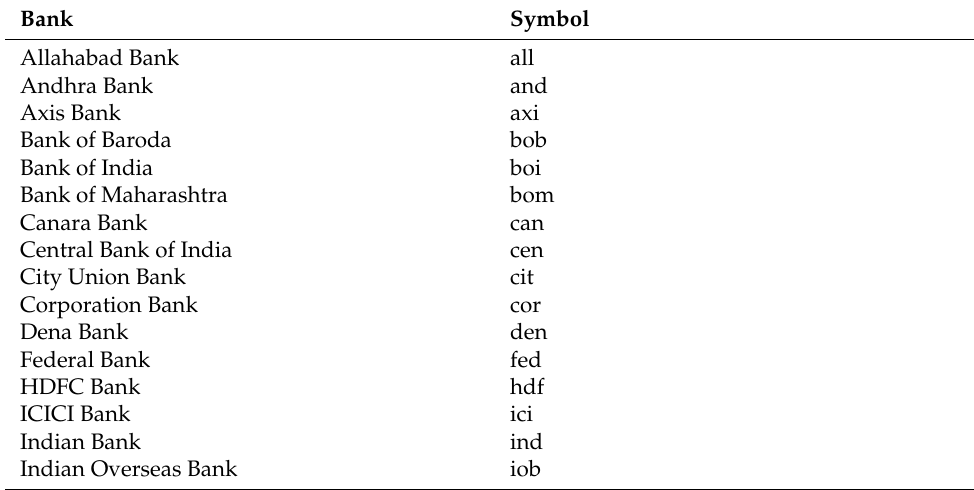
Table A3. Studied banks along with their